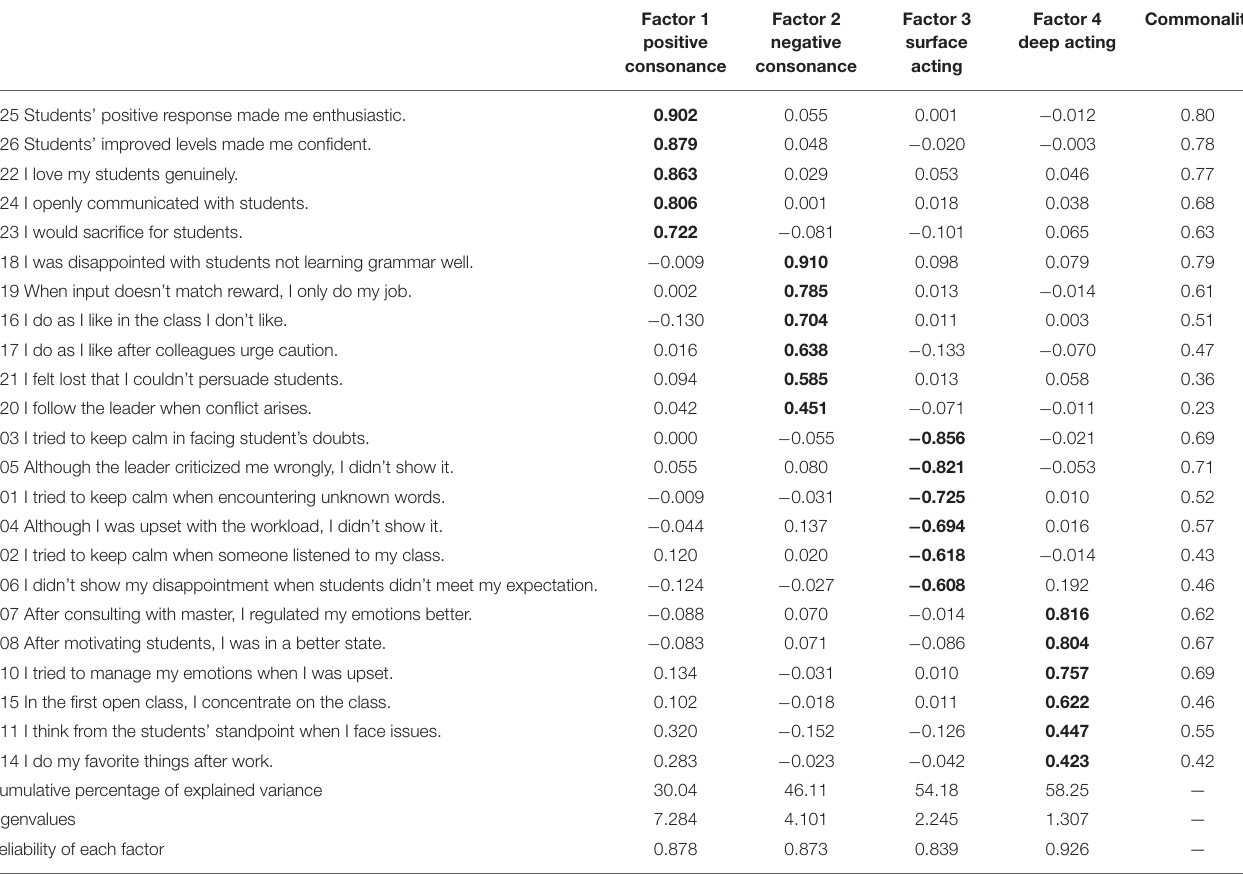
TABLE 2 | Results of EFA for emotional labor strategies.